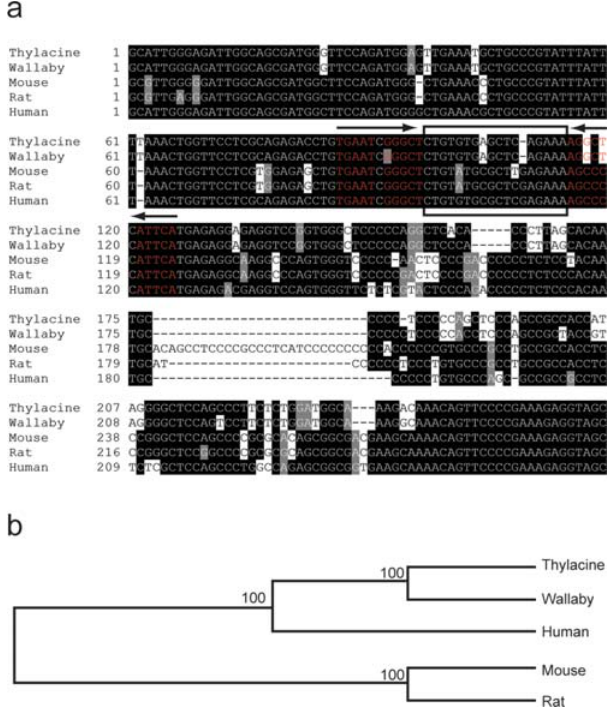
Figure 2. Analyses of the thylacine Col2a1 enhancer element. ( a ) Sequence alignment of the thylacine PCR cloned Col2a1 enhancer. Identical alignment between species is shown by black boxes. The thylacine sequence was most similar to, but distinct from that of another marsupial, the tammar wallaby, Macropus eugenii . The black box outlines the minimal 18-bp element. Inverted repeats (arrows) surrounding the minimal element are shown with complementary nucleotides in red. The outer repeat is highly conserved between all mammals, but the inner repeat differs by 2 nucleotides in the thylacine. ( b ) Phylogenetic analysis of the thylacine Col2a1 enhancer. The thylacine sequence groups with the tammar wallaby, both of which are more similar to the human sequence than to mouse or rat. Numbers indicate bootstrap values based on 100 replicates.